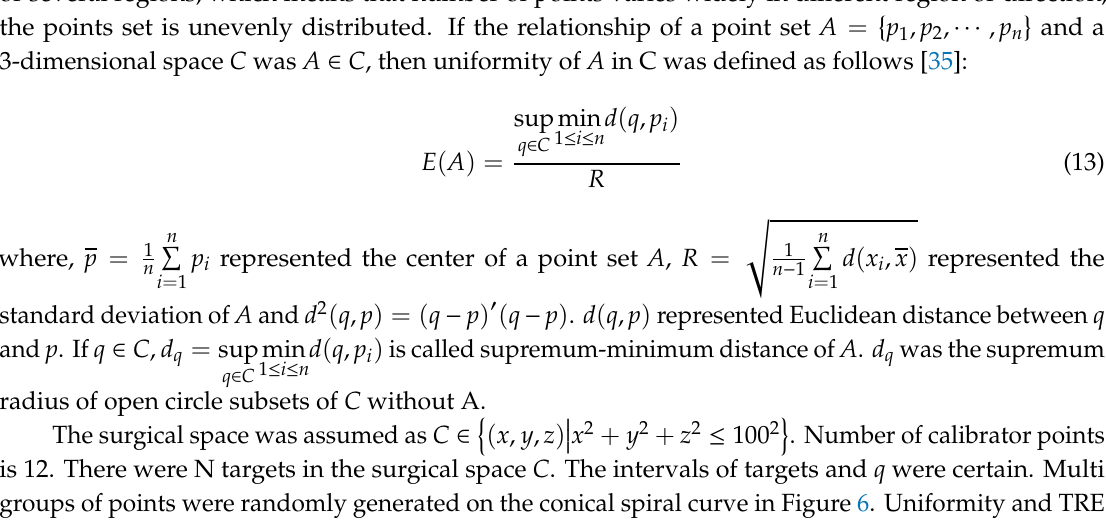
Figure 6. Relationship between uniformity of a points set and TRE. 3.